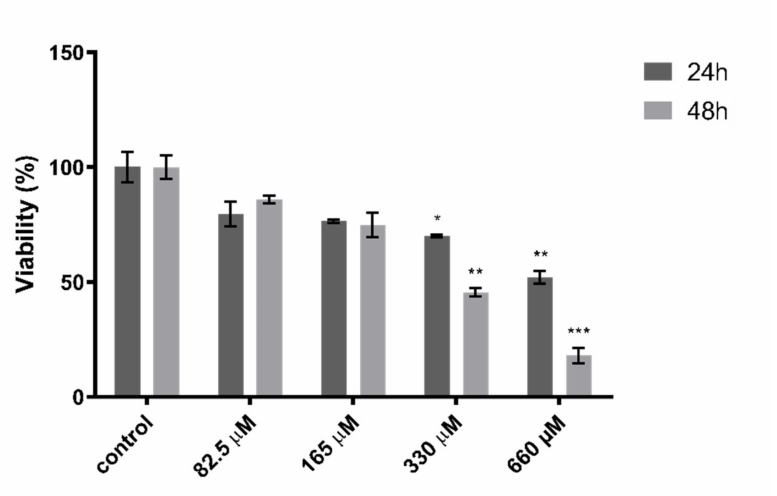
Figure 1. Effect of quercetin on HepG2 cells viability. Cells were treated with Quercetin at concentra- tions of 82.5, 165, 330, and 660 µ M for 24 and 48 h. Data are expressed as a percentage of the control group ± the standard error of the mean of three replicates from three independent experiments. Statistical significance was assessed by multiple t test followed by Holm–Sidak correction for multiple comparisons; * p < 0.05, ** p < 0.01, *** p <